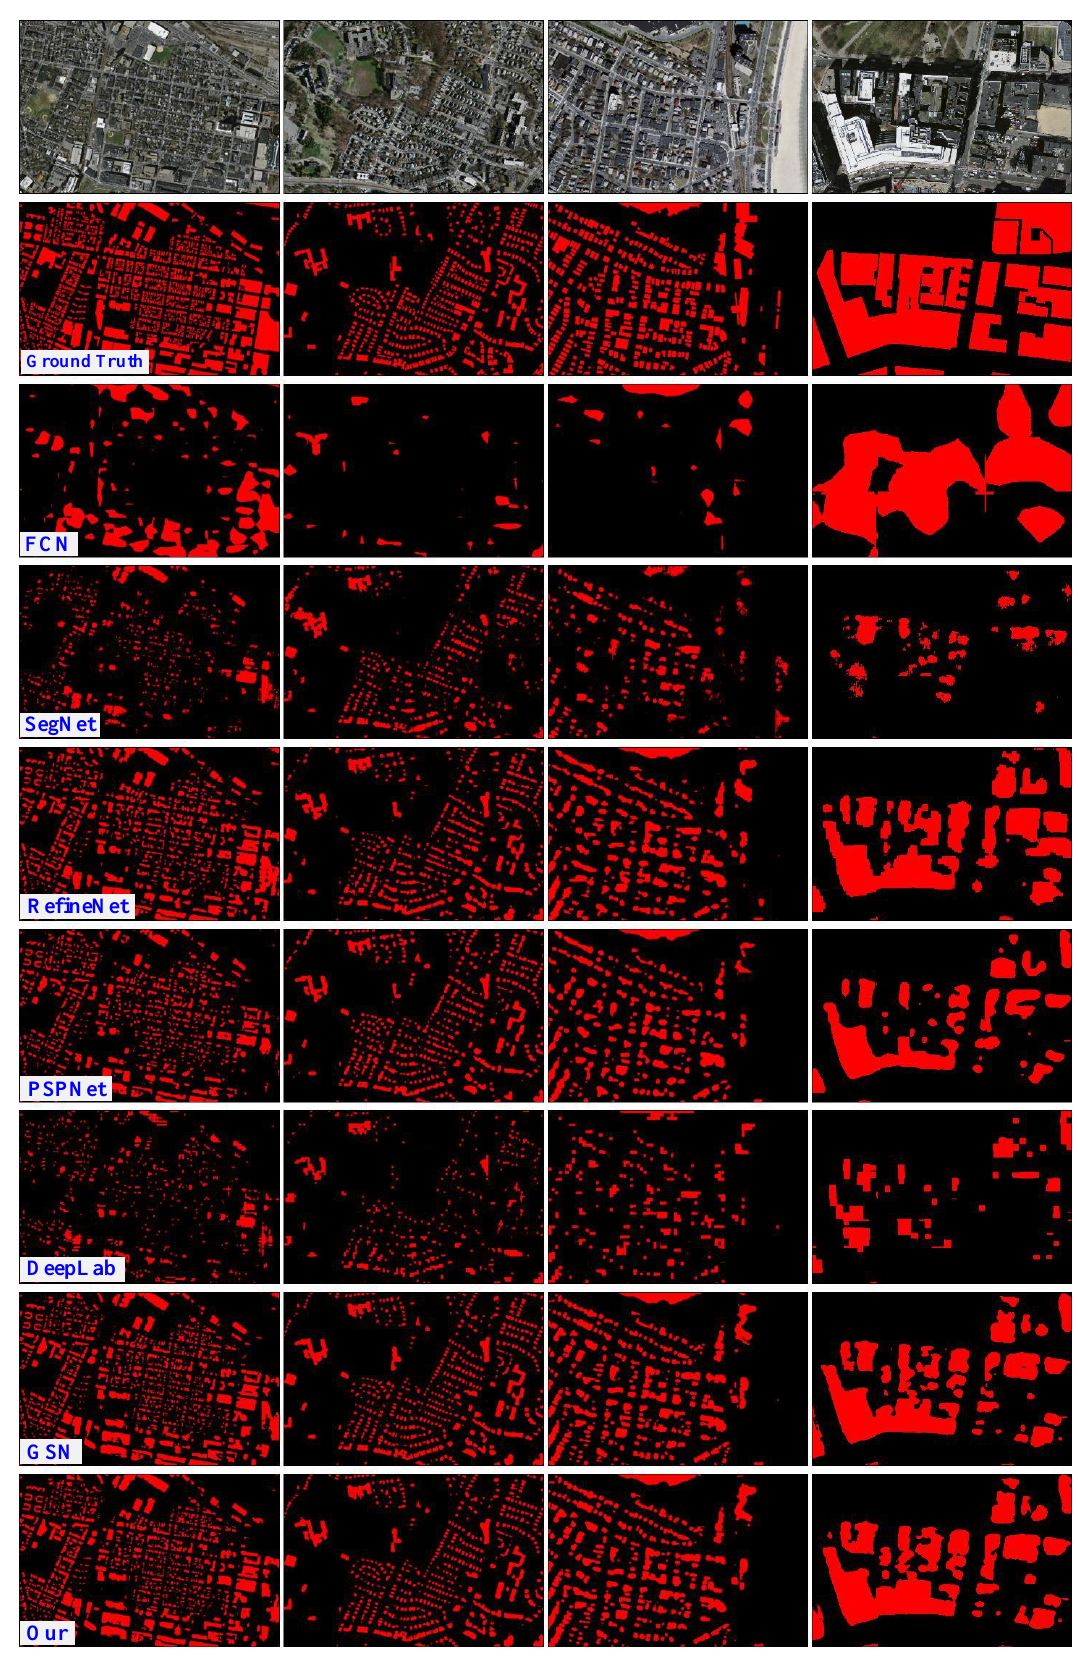
Figure 5. Visual comparisons between L-GCNN (ours) and other related methods on the Massachusetts building dataset. Label includes two categories: building (red) and nonbuilding